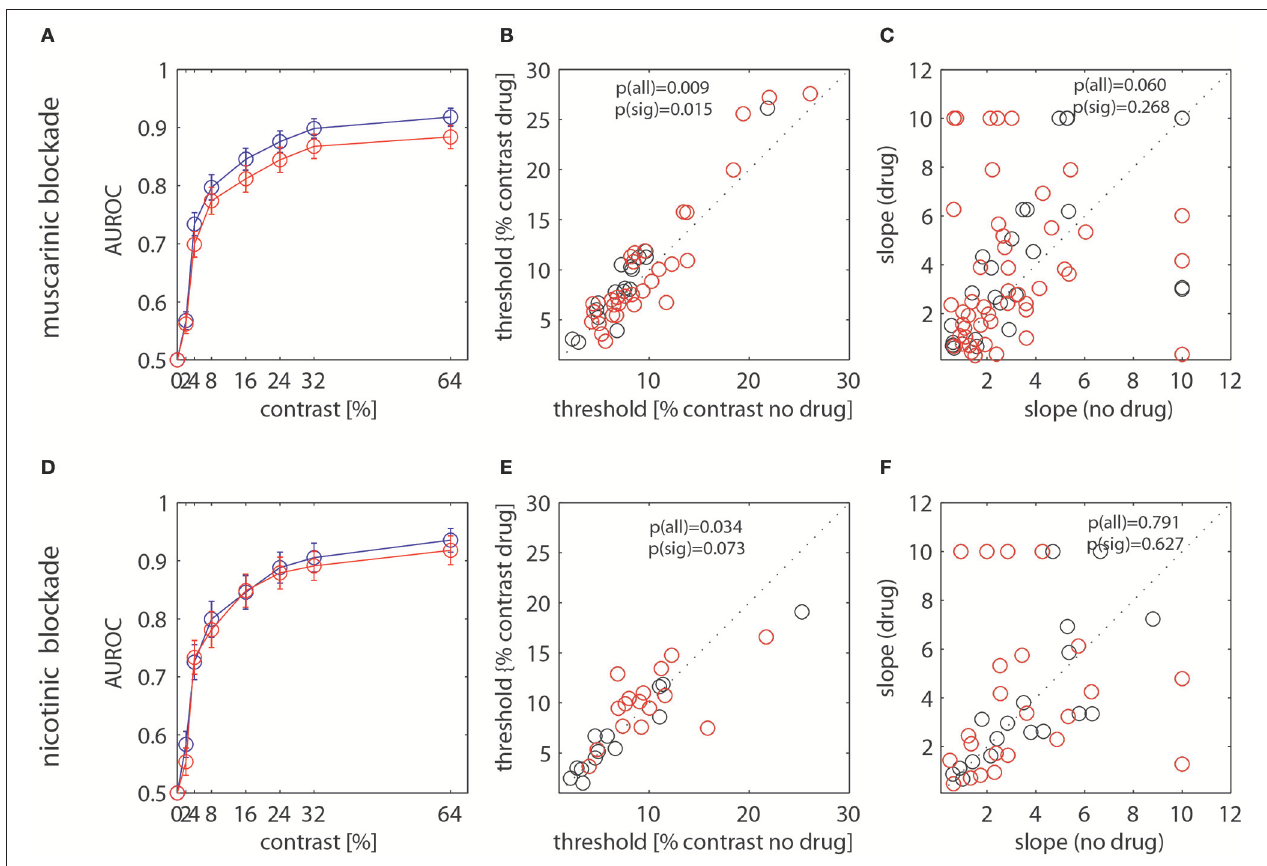
FIGURE 6 | Analysis of drug effects on neurometric functions. (A,D) AUROC values for the control (blue) and the drug (red) condition when scopolamine was applied. (B,E) Neuronal thresholds derived from the Weibull fits to the AUROC values for the control (abscissa). (C,F) Slope of the Weibull function at the threshold location. (A–C) show data when scopolamine was applied, (D–F) show data when mecamylamine was applied. Red dots show data were separate fits of the Weibull function yielded significantly better fits to the data than a single combined fit to the two data sets. Black dots show those were a single fit was not significantly worse than separate fits. P -value insets indicate whether the thresholds (slopes) derived from separate fits differed significantly for the control and the drug conditions (Wilcoxon signed rank test). P(all) indicates the comparison when all cells were taken into account, p(sig) show the comparison for cells that were significantly better fitted with separate